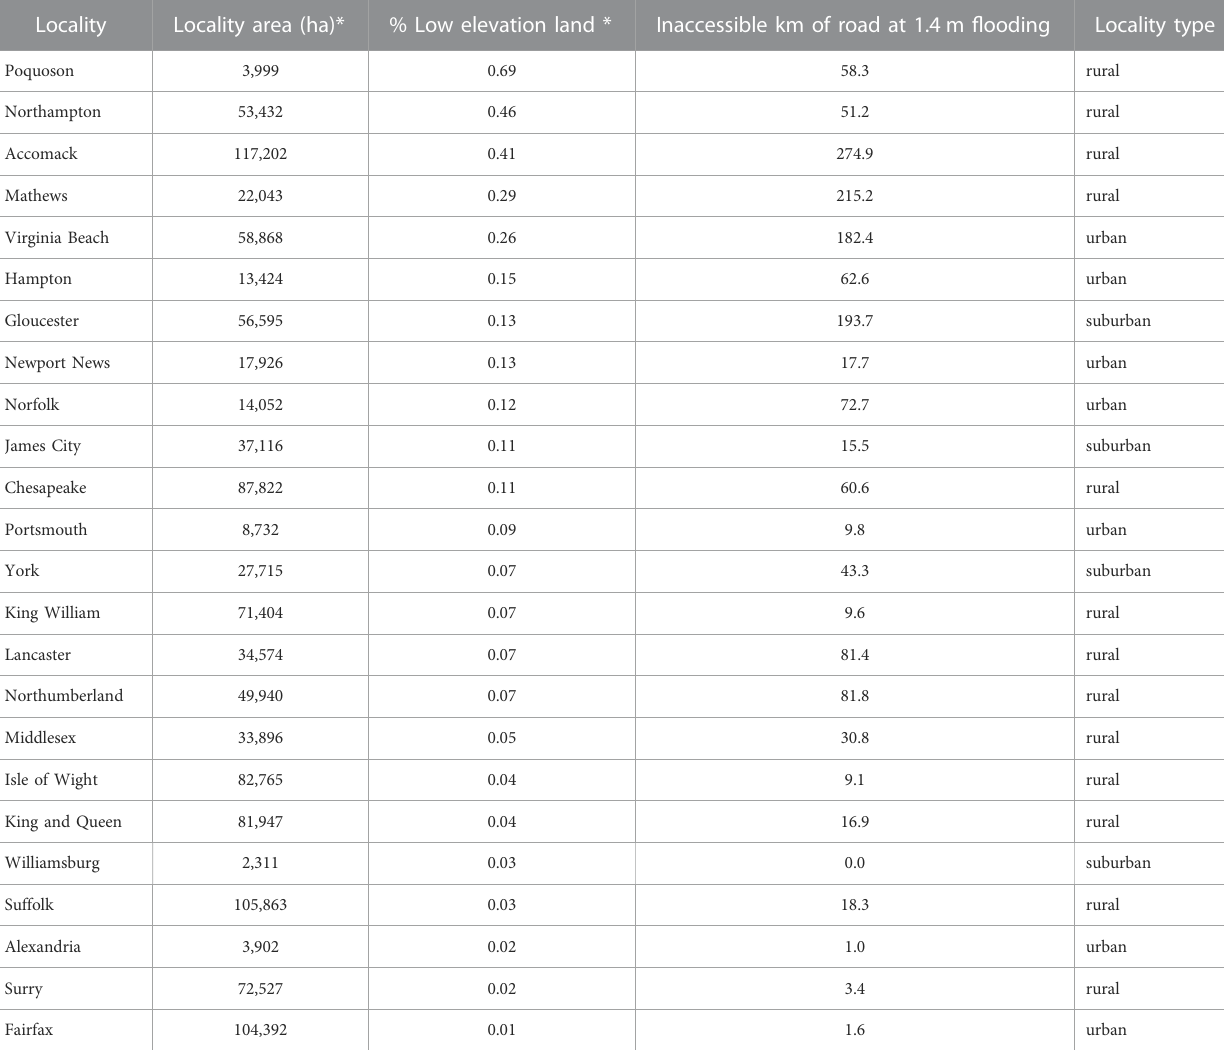
TABLE 1 Locality characteristics. Localities are arranged by the % of low elevation land ( fl ooded at 1.4 m water elevation) in the locality. * indicates data from Mitchell et al.